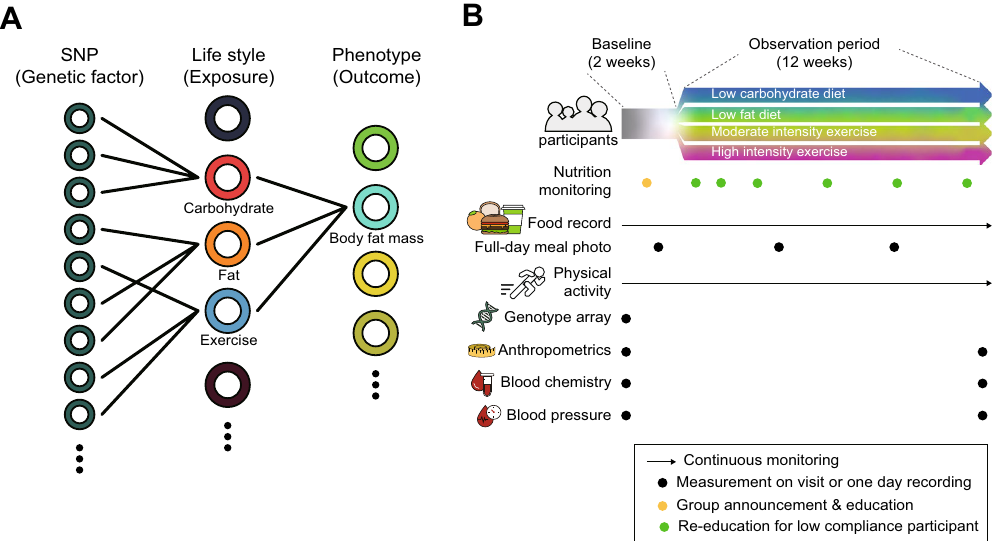
Figure 1. Genome, lifelog, anthropometric characteristics, and blood chemistry profiling. ( A ) Overview of the interaction of genetic and life style factors for body fat mass control. ( B ) Participants were classified into four groups: low-carbohydrate diet, low-fat diet, moderate-intensity exercise and high-intensity exercise groups. Nutrient intake and physical activities were recorded through 14 weeks. Genotypic data were collected at the beginning of the observation. Anthropometrics and blood chemistry data were measured at the beginning and the end of the